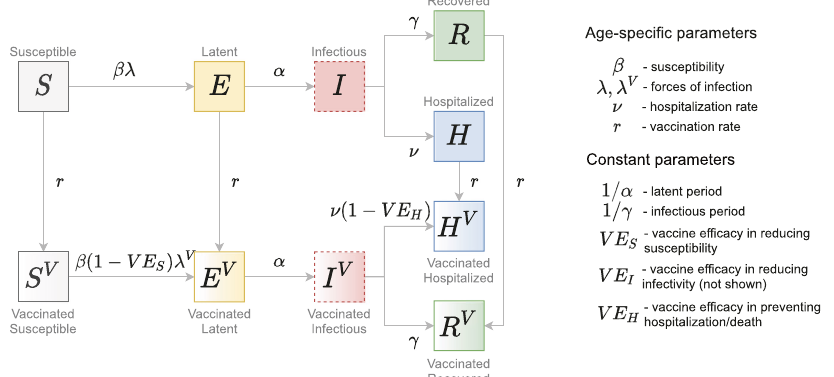
Fig. 8 Schematic of the transmission model. Gray arrows show epidemiological transitions. Red dashed boxes indicate compartments contributing to the forces of infection. The model is age-structured and involves an extended SEIR-type framework. Vaccinated persons may experience behavior compensation post-vaccination modeled as a return to pre-pandemic contact rates among vaccinated persons as compared to unvaccinated persons who may continue to have reduced contact rates due to control measures. The vaccine has three effects: (i) reduction in susceptibility of vaccinated relative to unvaccinated ( VE S ); (ii) reduction in infectivity of vaccinated relative to unvaccinated ( VE I , see Eqs. (3) and (4)); (iii) reduction in hospitalization rate of vaccinated relative to unvaccinated ( VE H